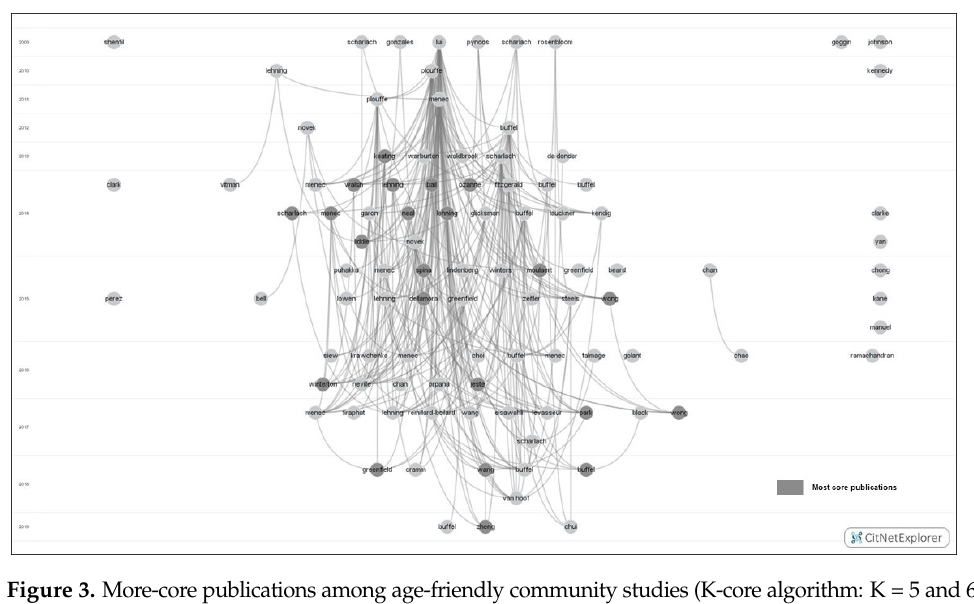
Figure 2. Most-core publications among age-friendly community studies (K-core algorithm: K = 7).